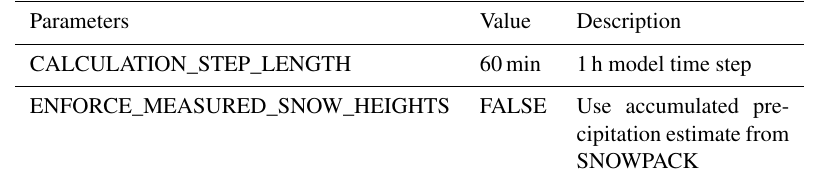
Table A4. Model parameter changes for Alpine3D from Table